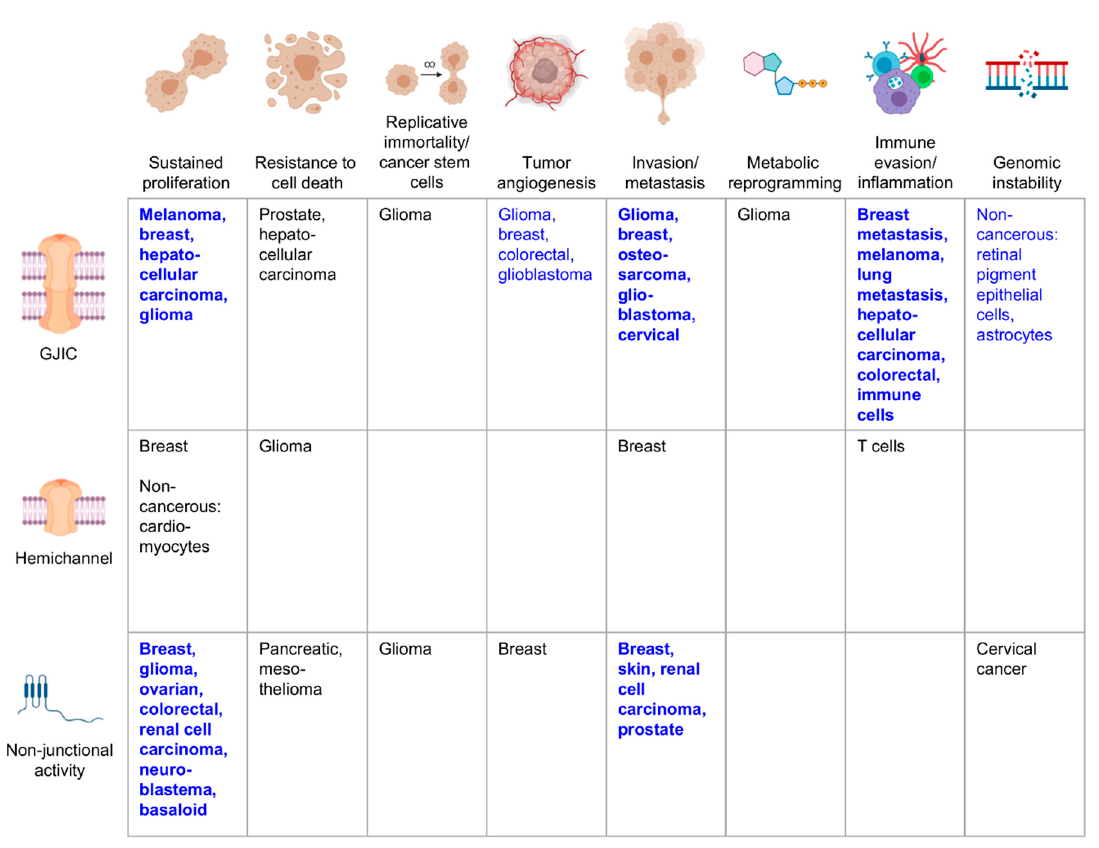
Figure 2. Cancers in which specific connexin functions have been described to be tumor suppressive. Schematic showing examples of the cancer types in which tumor suppressive properties have been attributed to a specific connexin function, whether gap junction intercellular communication (GJIC), connexin hemichannels, or a non-junctional function. Bold blue text indicates strong evidence from many cancer types tying the connexin function to the corresponding cancer hallmark, with blue text indicating a less robust link and black text indicating emerging evidence. Where mechanistic studies in cancer cells are not available, certain non-transformed cell populations are indicated. References for the indicated cancers are provided in the text. Figure illustrations generated using BioRender.com.